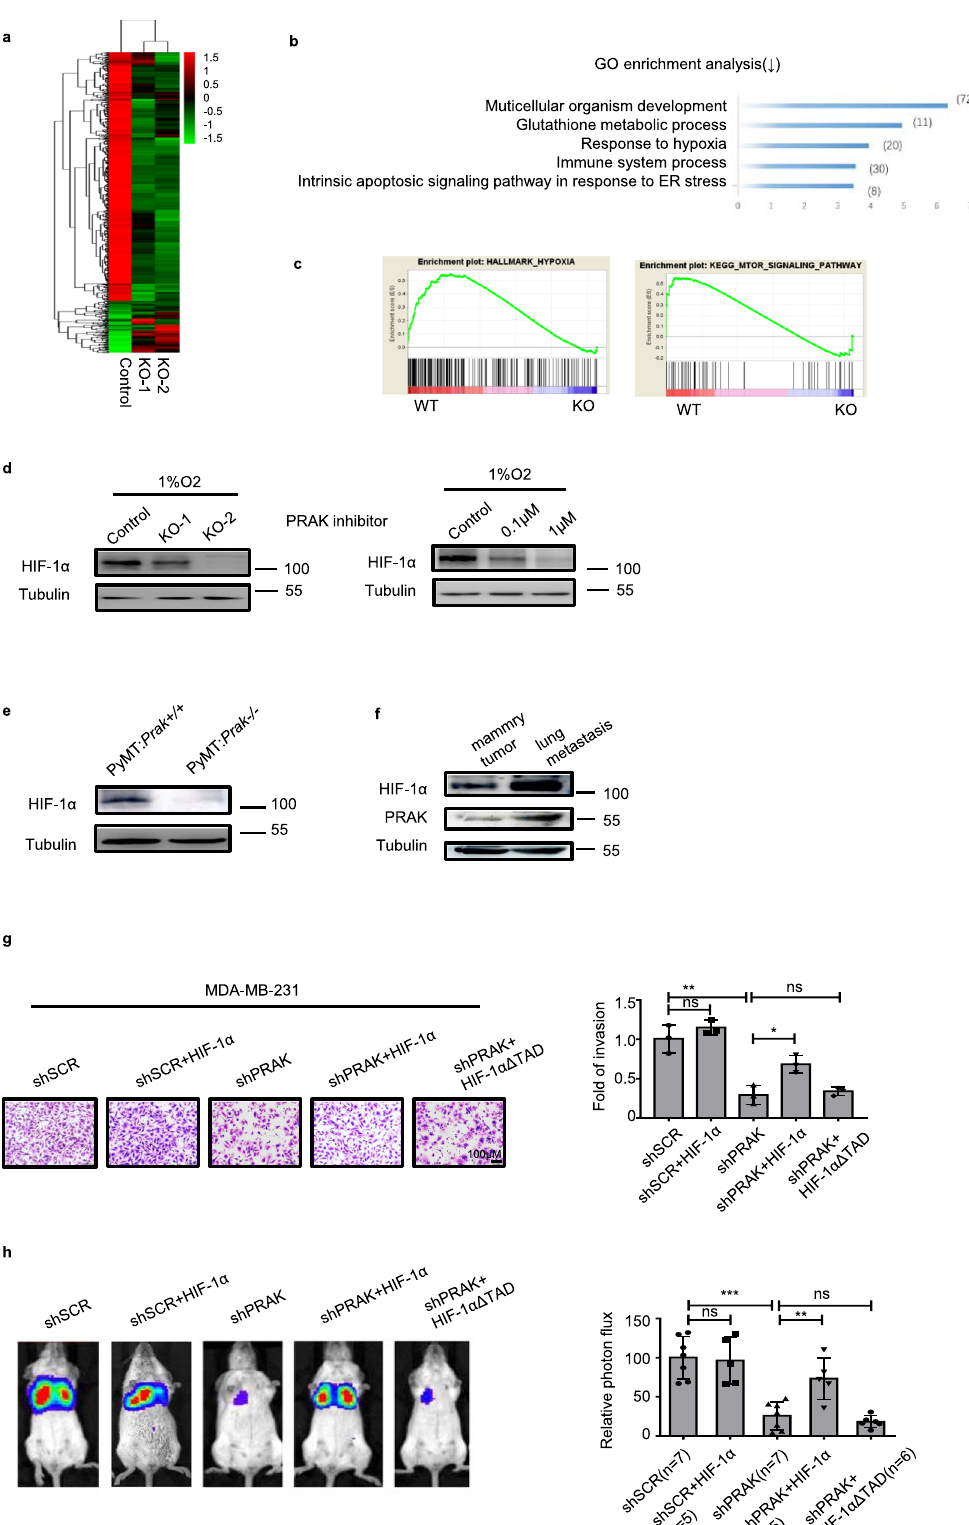
5 ’ TOP, including HIF-1 α mRNA 32,33 . PRAK deletion or inhibi- tion was noted to be associated with decreased phosphorylation of mTORC1 and its substrate S6K1. Treatment with the mTORC1 agonist MHY1485 led to partial recovery of the reduced HIF-1 α expression and invasiveness of Prak -deleted tumor cells. These data suggest that the pro-metastatic activity